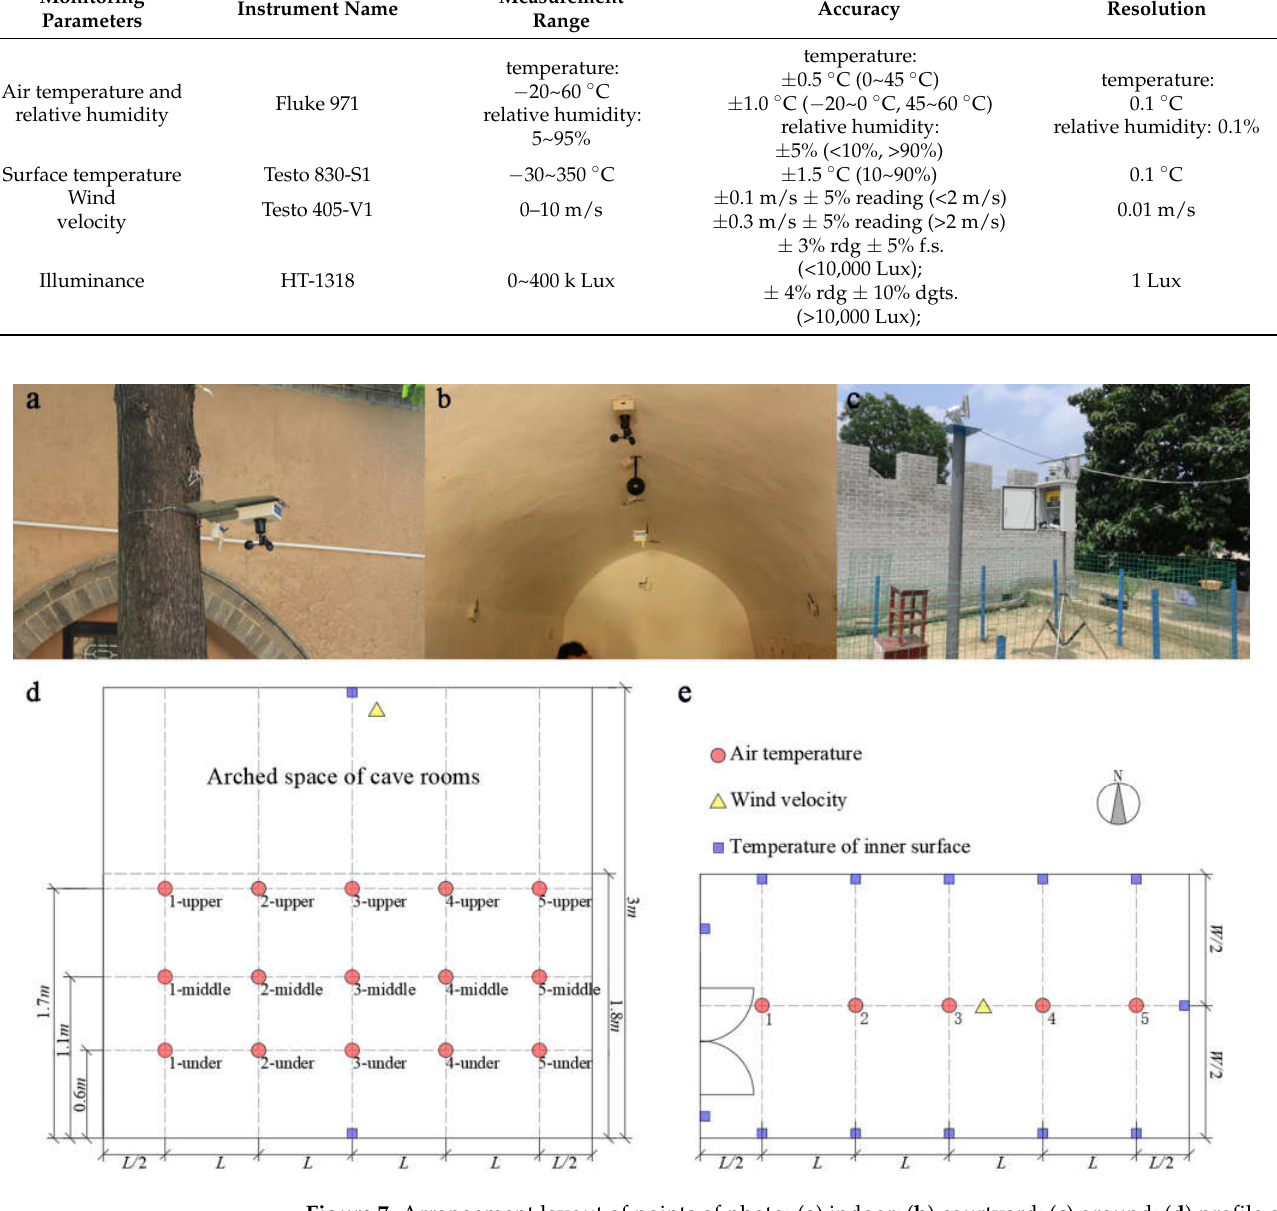
Figure 7. Arrangement layout of points of photo: ( a ) indoor; ( b ) courtyard; ( c ) ground; ( d ) profile of indoor points; ( e ) planar graph of indoor points.